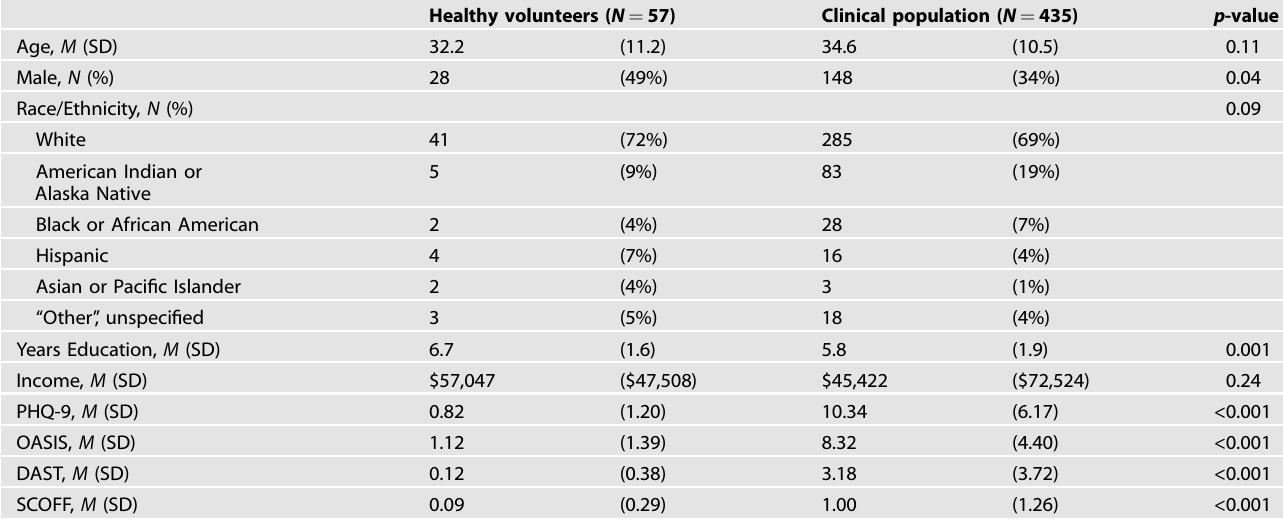
Table 1. Demographic and clinical characteristics of the study